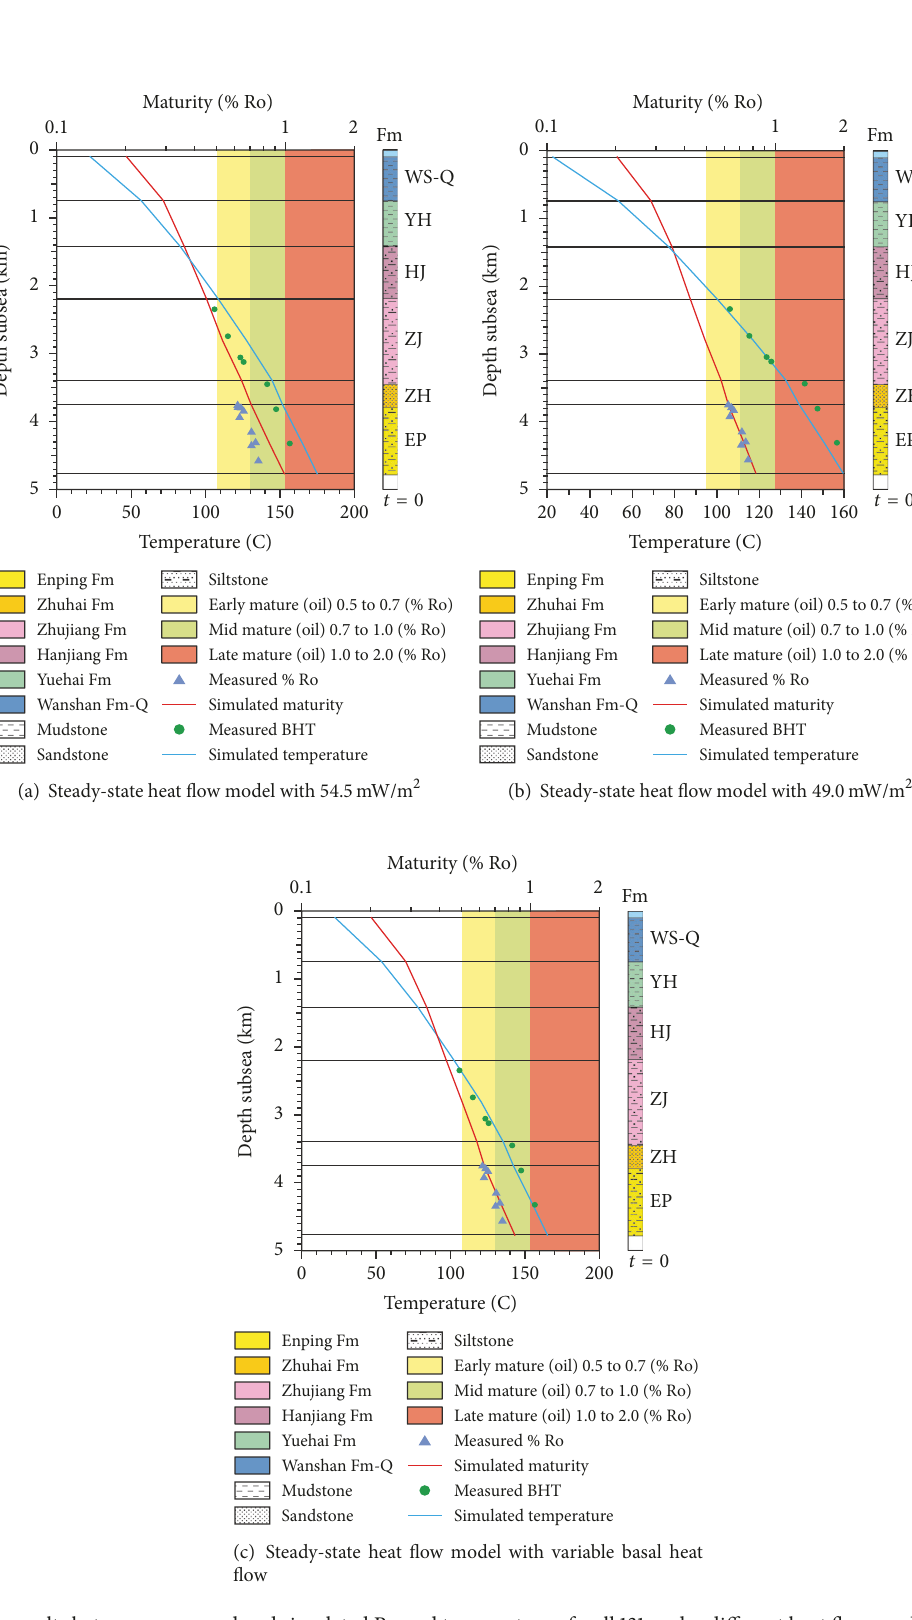
Figure 15: Fitting results between measured and simulated Ro and temperature of well 131 under different heat flow models. The locations of well 131 are shown in Figure 1 (formation names: EP = the Enping Fm; ZH = the Zhuhai Fm; ZJ = the Zhujiang Fm; HJ = the Hanjiang Fm; Yh = the Yuehai Fm; WS = the Wanshan Fm; Q =